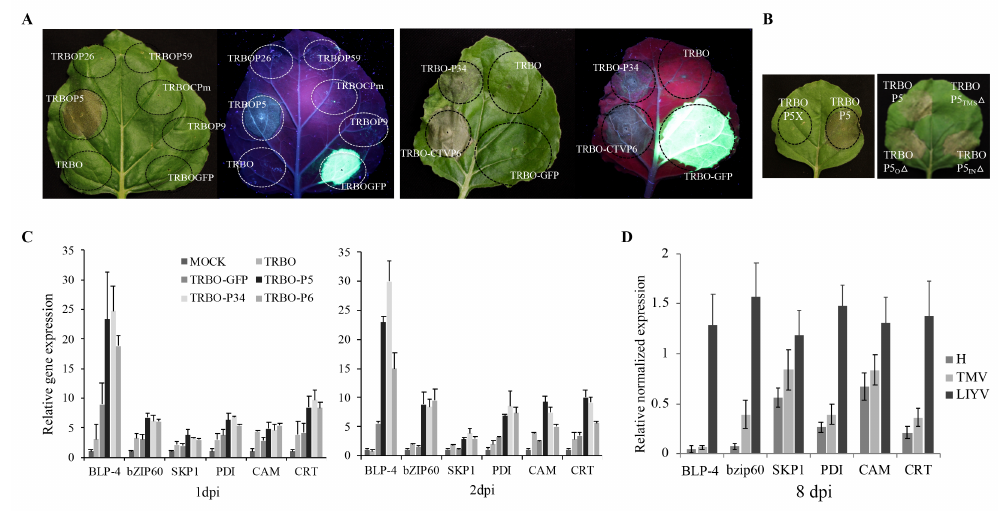
Figure 7. LIYV P5 causes cell death when expressed from a Tobacco mosaic virus (TMV) vector. ( A ) Expression of the LIYV P26, P59, CPm, P9, P34, P5 and Citrus tristeza virus (CTV) P6 from TRBO vector [29] on Nicotiana benthamiana leaves through agroinfiltration. Empty vector and vector expressing GFP were used as controls. GFP expression was visualized under UV light at 4 dpi. ( B ) Evaluation of different regions of LIYV P5 contributing to cell death on N. benthamiana leaves. ( C ) Quantification of BLP-4, bZIP60, SKP1, PDI, CRT, and CAM transcript abundance on N. benthamiana leaves inoculated dpi. ( D ) Quantification of BLP-4, bZIP60, SKP1, PDI, CRT, and CAM transcript abundance on